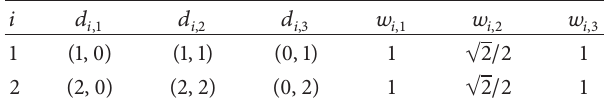
Table 3: Control vertex and weight factor of Section